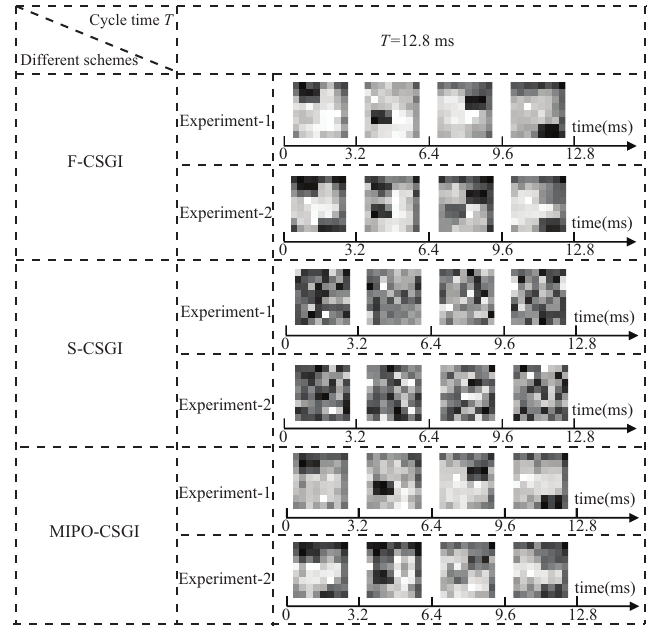
Figure 6. Experimental results of reconstructing four frames of a jumping “square” using F-CSGI, S-CSGI, and MIPO-CSGI.